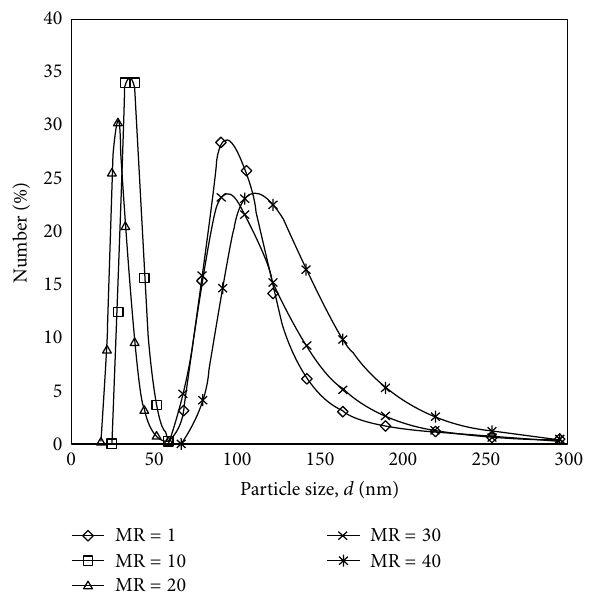
MR on particle size using 3